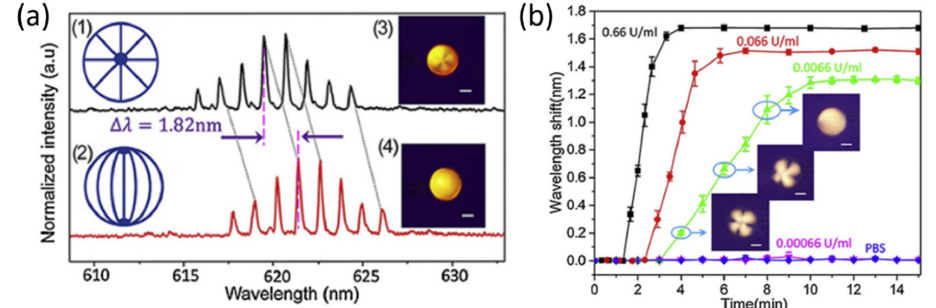
Figure 26. ( a ) Spectral shifts for corresponding configurations. ( b ) shift response for increasing concentrations of AChE. Reproduced from ref. [118] with permission from Elsevier.